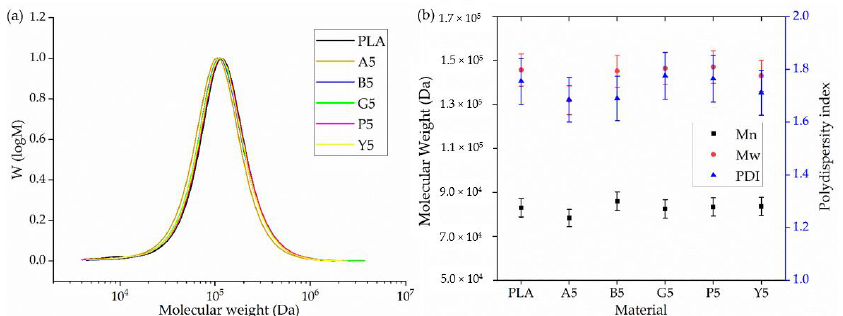
Figure 8. GPC analysis of PLA and its master batches containing 5% ( w / w ) of each colorant. ( a ) GPC elugram with normalized intensity on the y-axis. ( b ) Mean M w , M n , and PDI values ± SE ( n = 3).